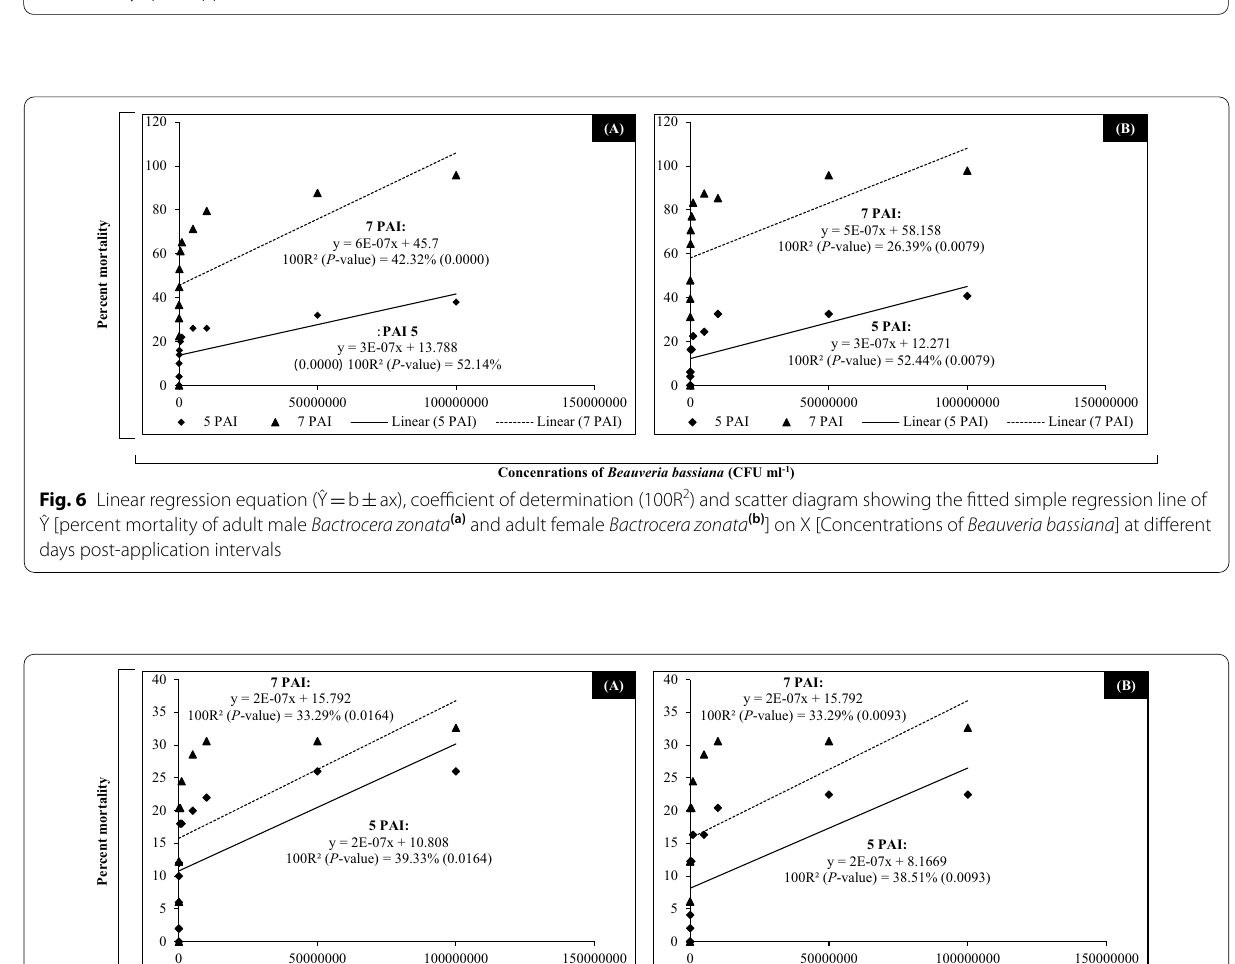
Fig. 5 Linear regression equation (Ŷ b ax), coefficient of determination (100R 2 ) and scatter diagram showing the fitted simple regression line = ± of Ŷ [percent mortality of adult male Bactrocera zonata (a) and adult female Bactrocera zonata (b) ] on X [Concentrations of Metarhizium anisopliae ] at different days post-application intervals